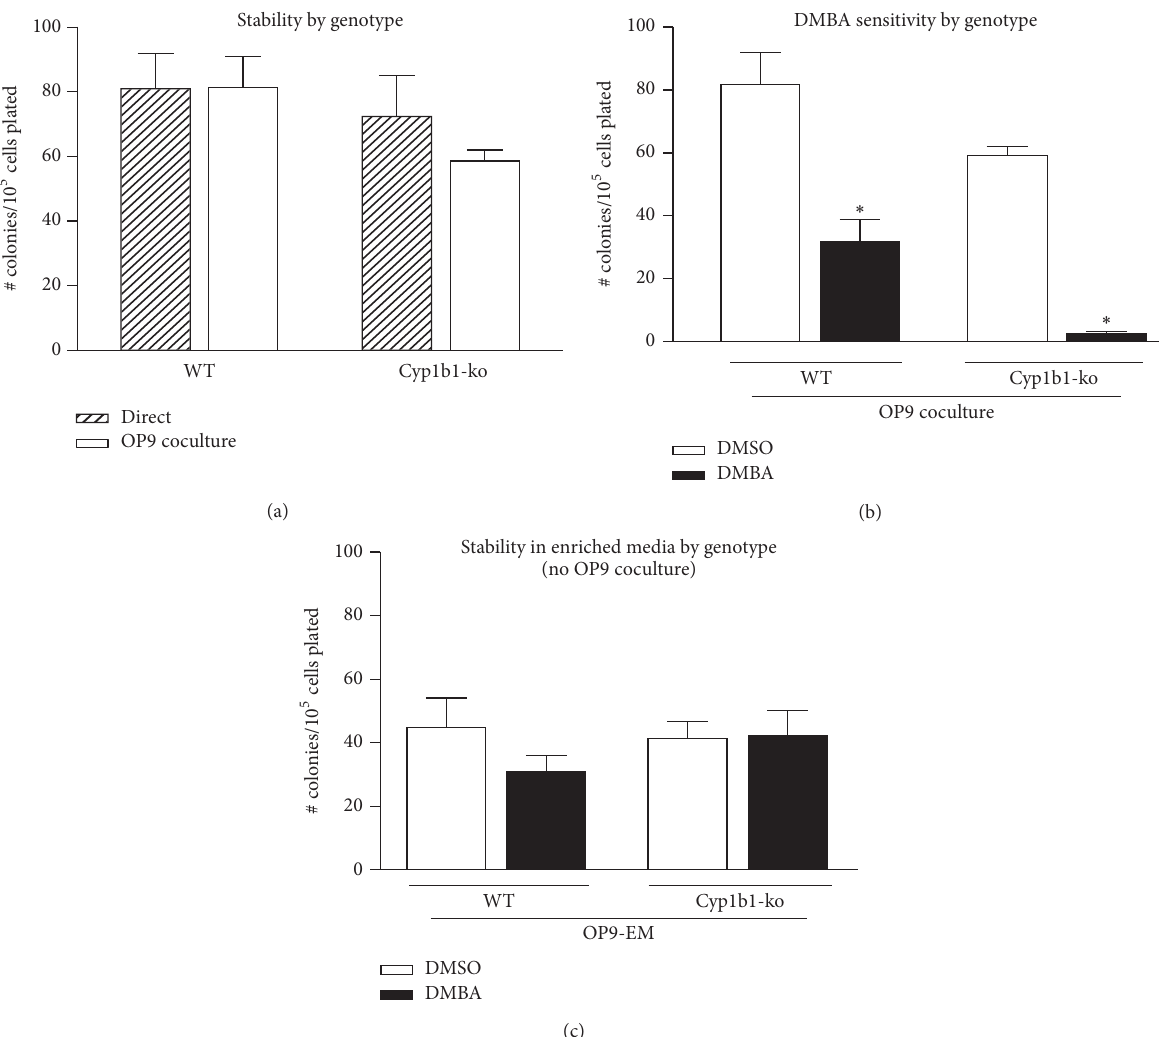
Figure 5: Comparison of WT and Cyp1b1-ko BMC with respect to PreB CFU progenitor cell activity. (a) Comparison of PreB CFU activity from BMC immediately after isolation (direct) and after 24-hour OP9 coculture. (b) Comparison of the PreB CFU activities for BMC after 24-hour solvent control (DMSO) and DMBA (1 𝜇 M) treatments, using OP9 coculture conditions. ∗ 𝑝 < 0.05 . (c) Comparison of the PreB CFU progenitor cell activity for WT and Cyp1b1-ko BMC after 24-hour solvent control (DMSO) and DMBA (1 𝜇 M) treatments in OP9 enriched medium